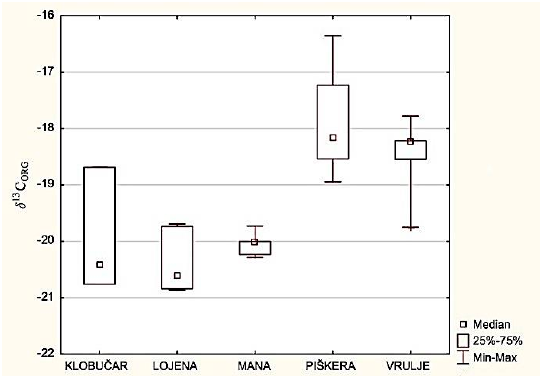
Figure 2. Box-plot diagrams of the δ 13 C org values of the sediment from different locations.